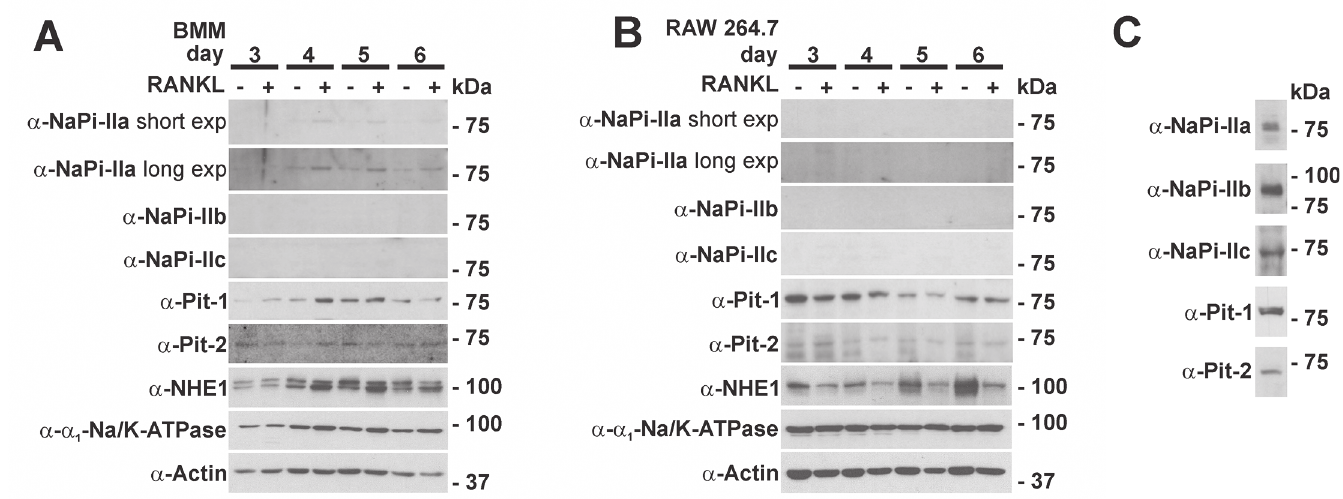
Fig 4. Western Blot analysis of type II and III phosphate transporters during osteoclast differentiation. A) BMMs or B) RAW 264.7 cells were cultured with or without RANKL for a total of 6 days. At day 3 to 6 cell lysates were prepared and equal amounts of protein (50 μ g) were separated by SDS-PAGE and probed with indicated antibodies. In contrast to BMM cultures (A), no NaPi-IIa signal was detectable in the RAW 264.7 cell cultures (B). No NaPi-IIb and NaPi-IIc signal was detected in both cell types irrespective of the presence or absence of RANKL. Both Pit-1 and Pit-2 are expressed during osteoclast differentiation. (C) Validation of antibodies using kidney lysate for detection of NaPi-IIa, NaPi-IIc, Pit1 and Pit2 and ileum mucosa for NaPi-IIb. Blots are representative of two independent experiments. NHE1: sodium/proton exchanger 1.